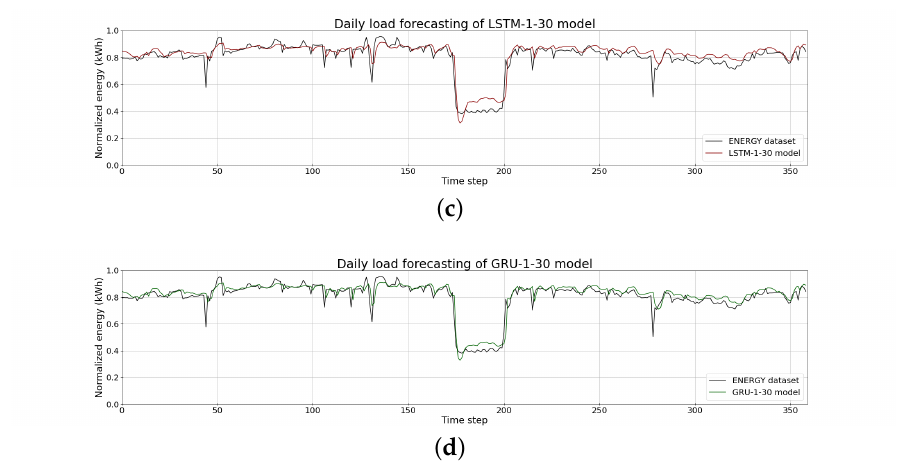
Figure 9. Daily load forecasting using ( a ) the RNN-1-30 model, ( b ) the RNN-4-30 model, ( c ) the LSTM-1-30 model, and ( d ) the GRU-1-30 model.